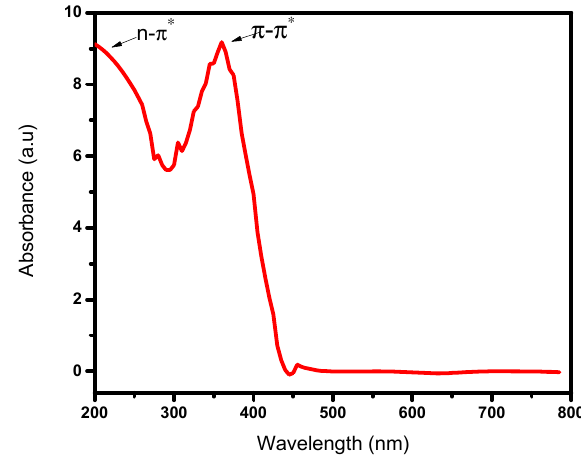
Figure 6. UV-Vis spectrum of CS-NM bio-composite.